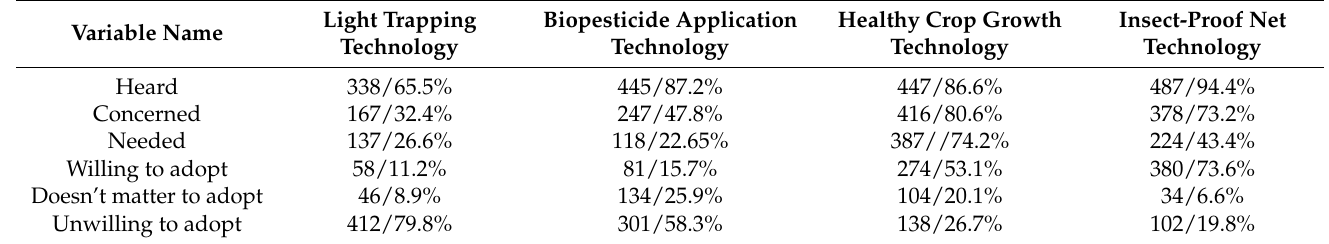
Table 4. Statistics of farmers’ responsive attitudes to pesticide reduction technologies